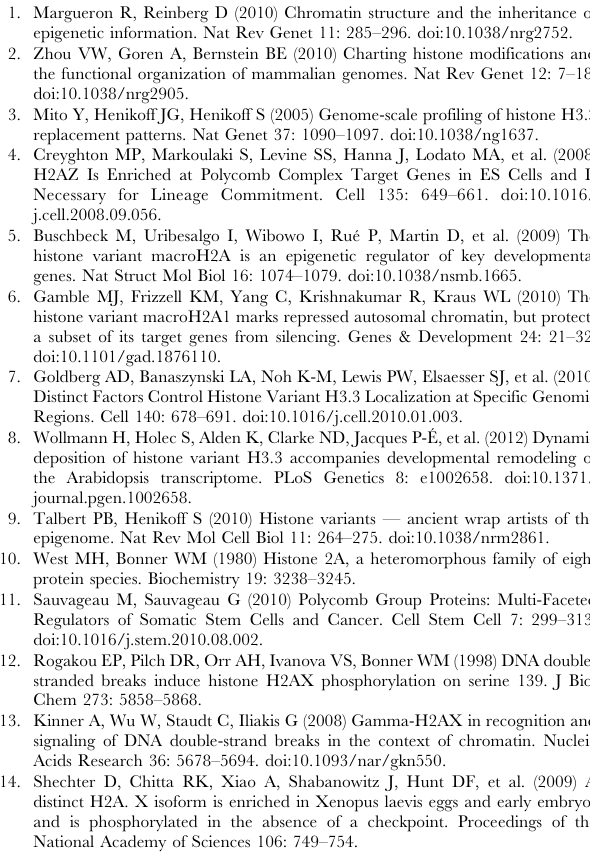
expression levels. Enrichment of histone variants at promoters (TSS 6 2 kb) in each group is shown as a box plot. (TIF) Figure S10 Enrichment of histone variants in the bodies of HCP and LCP genes. Genes were classified into HCP & active, HCP & inactive, LCP & active, and LCP & inactive on the basis of CpG density at the promoter and gene expression levels. Enrichment of histone variants at gene bodies (TSS + 2 kb , TES) in each group is shown as a box plot. (TIF) Table S1 Classification of the genes by their expression levels and the CpG density at promoter. (TIF) Table S2 The number of reads uniquely mapped to the genome for all ChIPseq and Inputseq data sets.